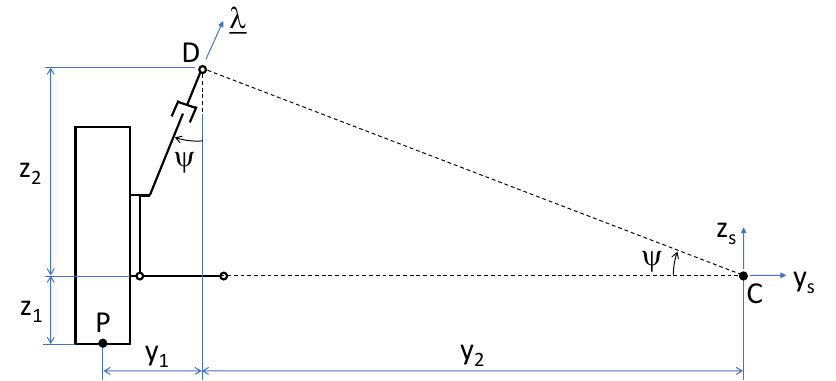
Figure 9. McPherson